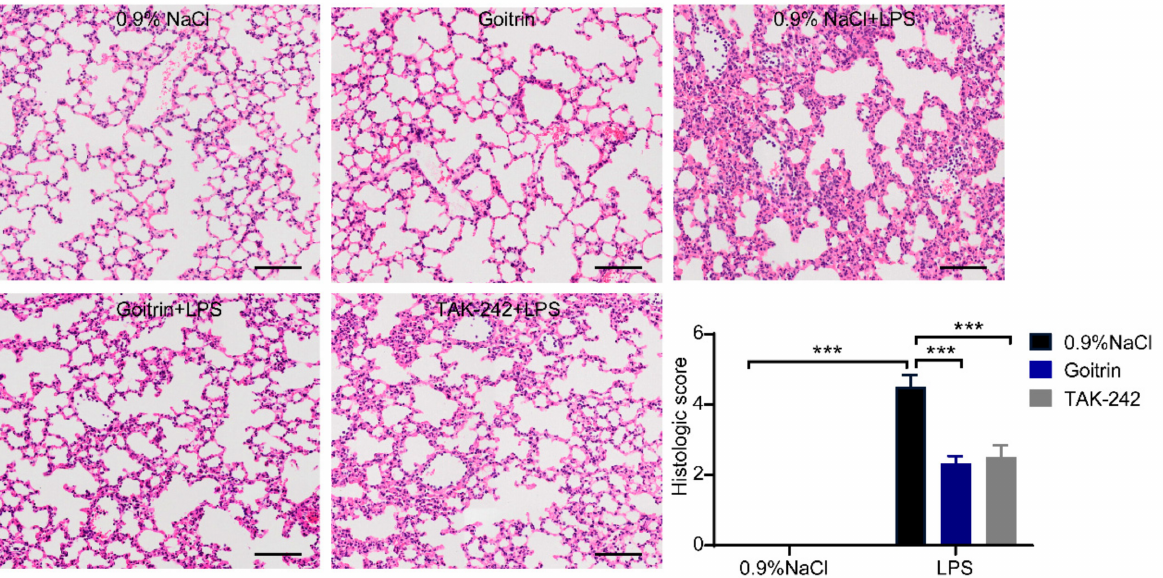
Figure 4. Goitrin reduced lung injury and inflammatory cell infiltration. Mice were peritoneally injected with 0.9% NaCl, goitrin (30 mg/kg), or TAK-242 (3 mg/kg) 1 h before LPS (20 mg/kg) intravenous injection ( n = 6). Pathological analysis of the mice livers and lungs after LPS injection for 8 h was determined using hematoxylin and eosin staining (scale bar = 50 µ m). Then, lung tissue injury was scored by a blinded assessment method for five categories. The data are presented as the means ± SD. *** p < 0.001 (ANOVA LSD